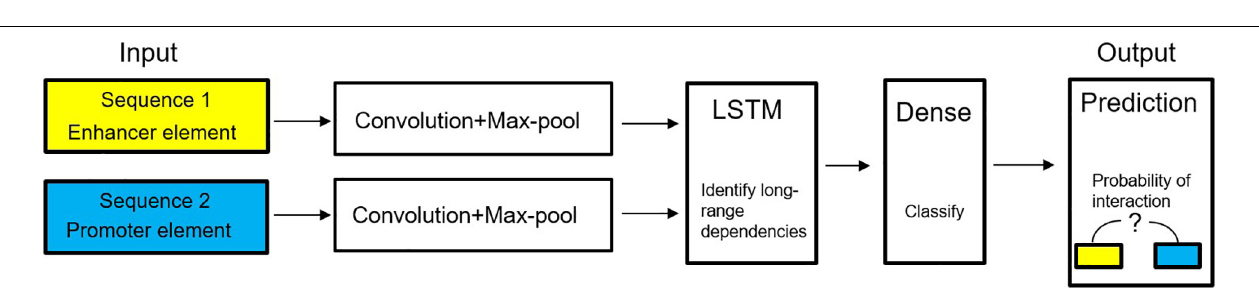
FIGURE 12 | Diagram of deep learning model to predict enhancer–promoter interactions (Chen Y. et al., 2016).